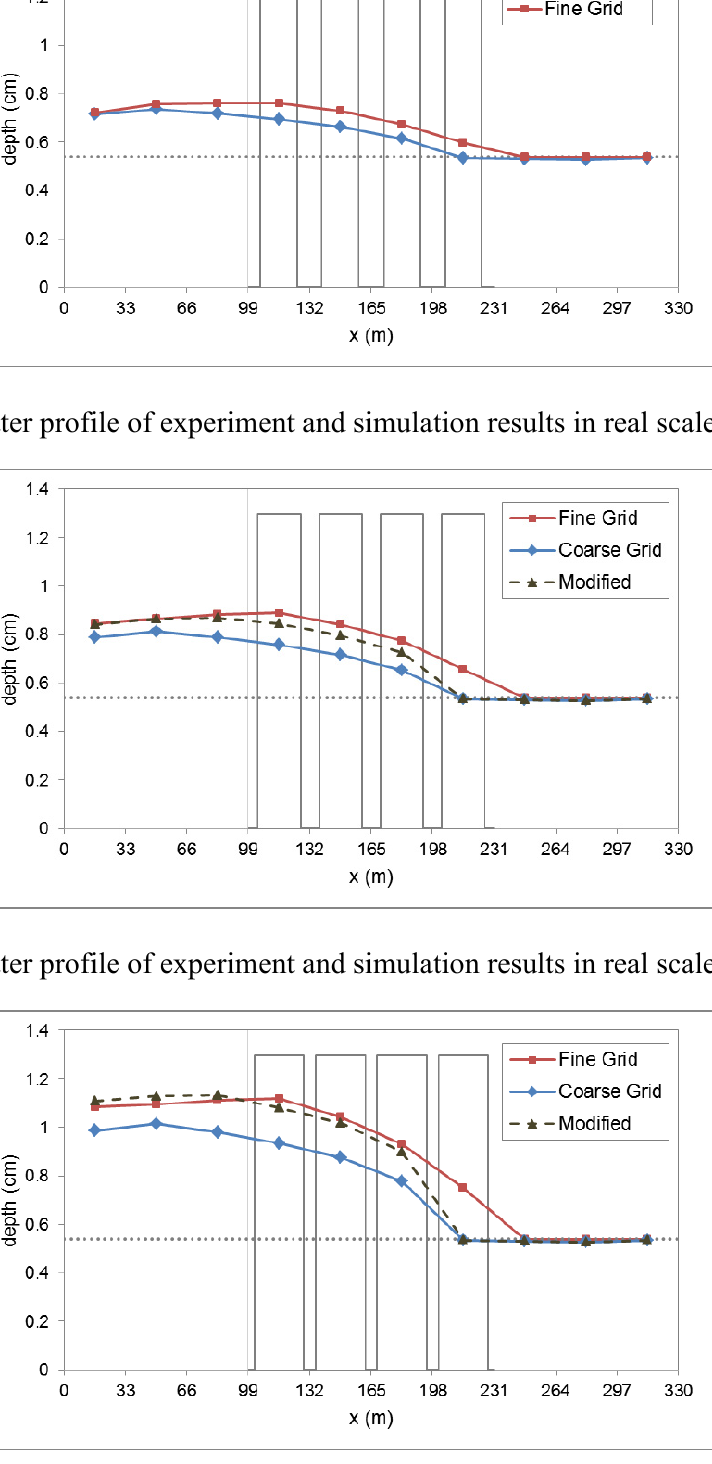
Figure 13. Water profile of experiment and simulation results in real scale ( α